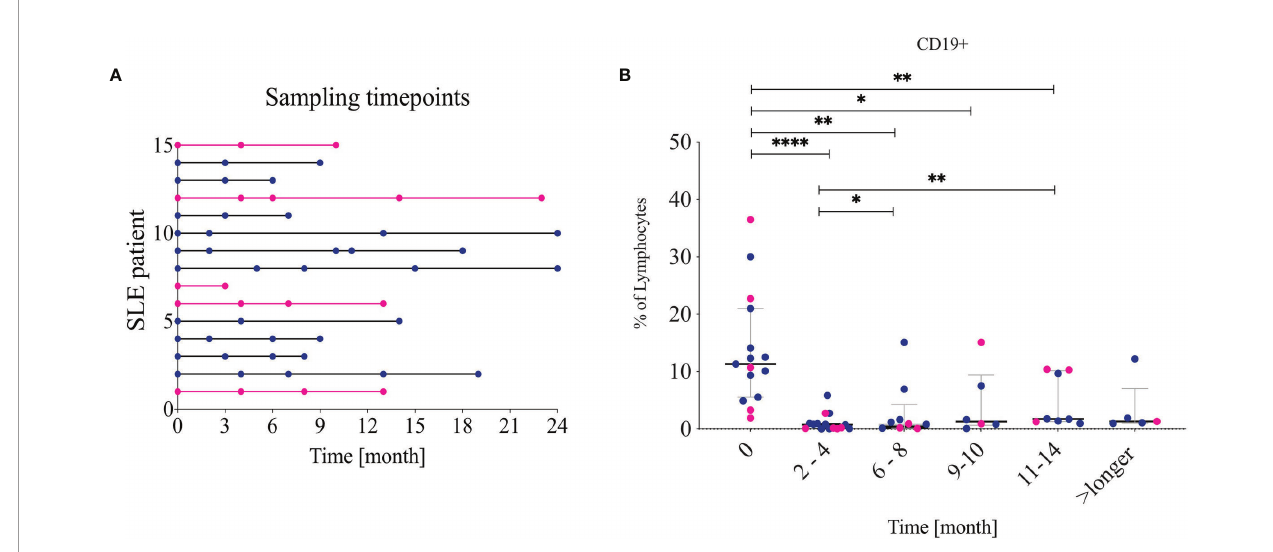
FIGURE 1 | Sample timepoints and CD19 frequency (A) Shows which patient contributed to which timepoints. Pink lines indicate non-lupus nephritis patients. The follow-ups were combined into fi ve different timepoints: 2-4, 6-8, 9-10, 11-14 and over 14 (longer). (B) Frequency of CD19+ cells from living lymphocytes over time. Lupus nephritis patients are indicated in blue while non-lupus nephritis patients are indicated in pink. * <0.05, **0.00...; ***